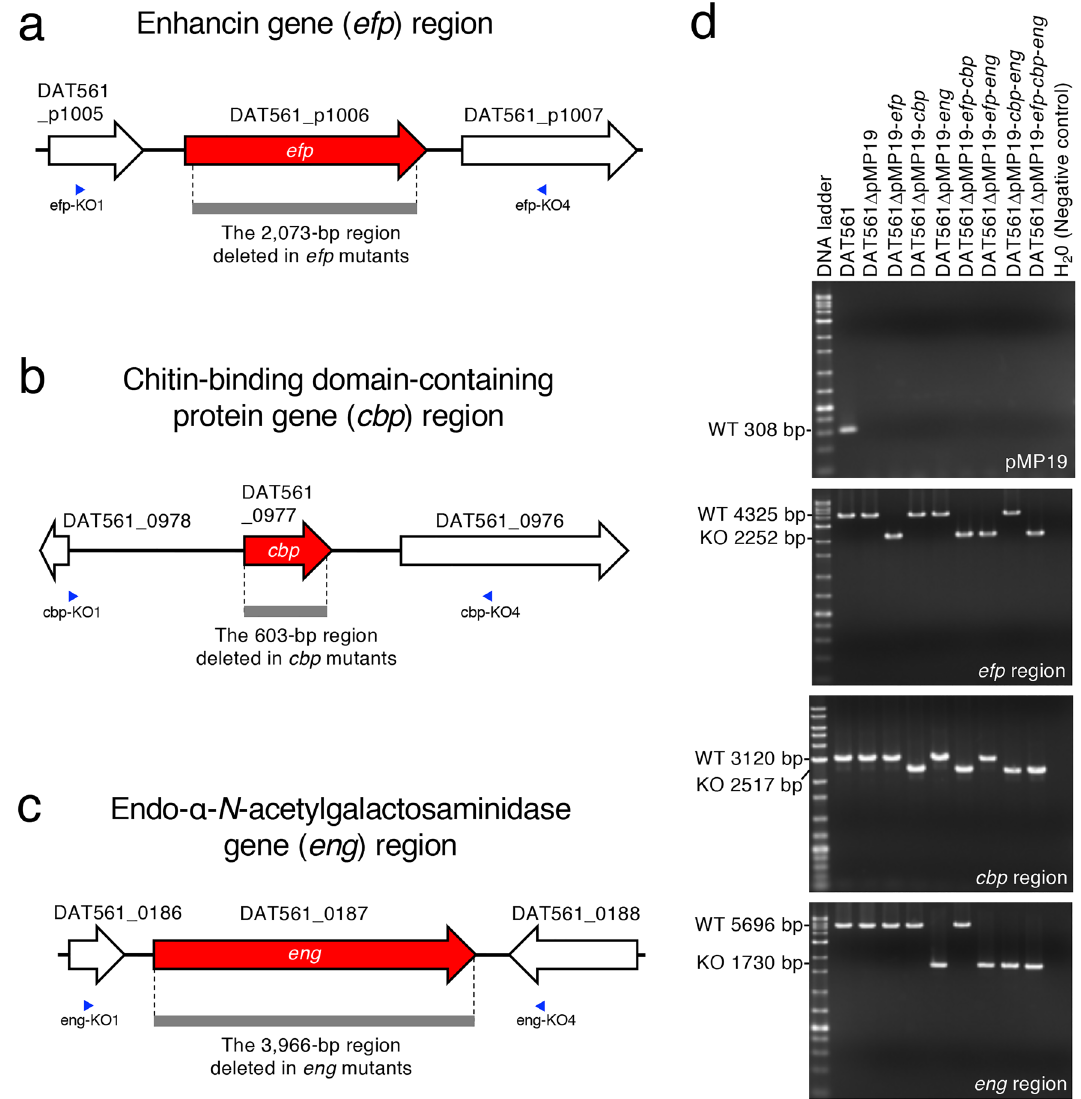
Figure 2. Schematic representation of the enhancin gene ( efp ) ( a ), chitin-binding domain-containing protein gene ( cbp ) ( b ) and endo-α- N -acetylgalactosaminidase gene ( eng ) ( c ) regions of DAT561. Gray bars represent regions deleted in the mutants constructed in this study. Blue arrowheads represent primers used to confirm deletion of the target genes. ( d ) Detection of pMP19 and confirmation of the target gene deletions in the constructed mutants by PCR. The primers, enzyme and PCR conditions are listed in Supplementary Table S1. Except for DAT561, M. plutonius strains used in this study lost pMP19. In each gene deletion mutant, the target regions were deleted as